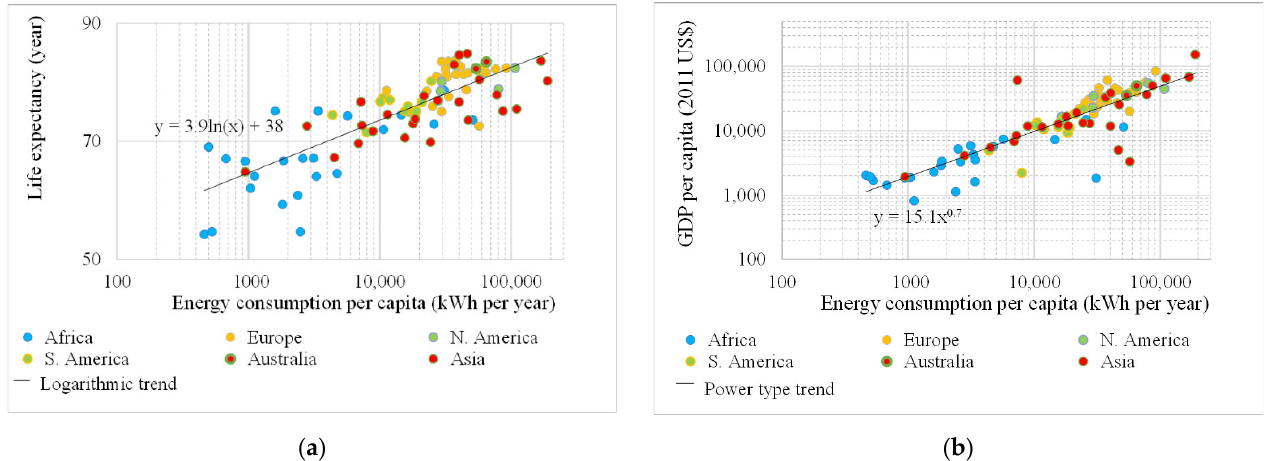
Figure 6. Energy consumption (2020) related to: ( a ) life expectancy; ( b ) GDP per capita (data from [106,108]).